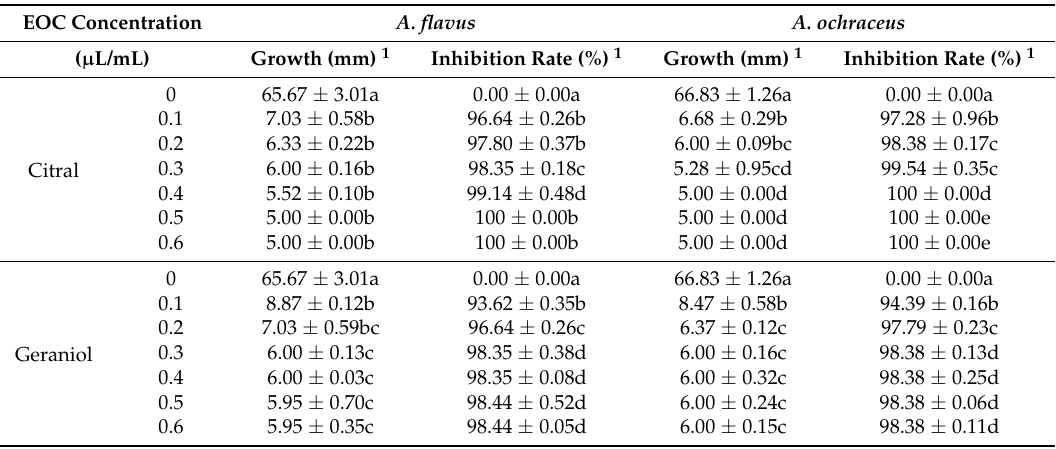
Table 1. Antifungal effects of citral and geraniol in different concentrations in the vapor phase against toxigenic fungi on potato dextrose agar (PDA)